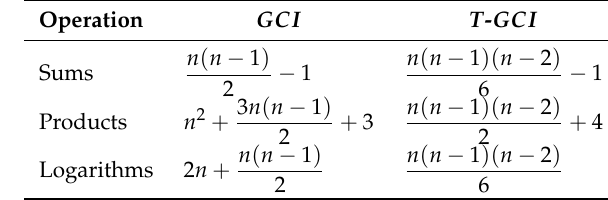
Table 1. Computational Complexity of GCI and T - GCI . Operation GCI T - GCI